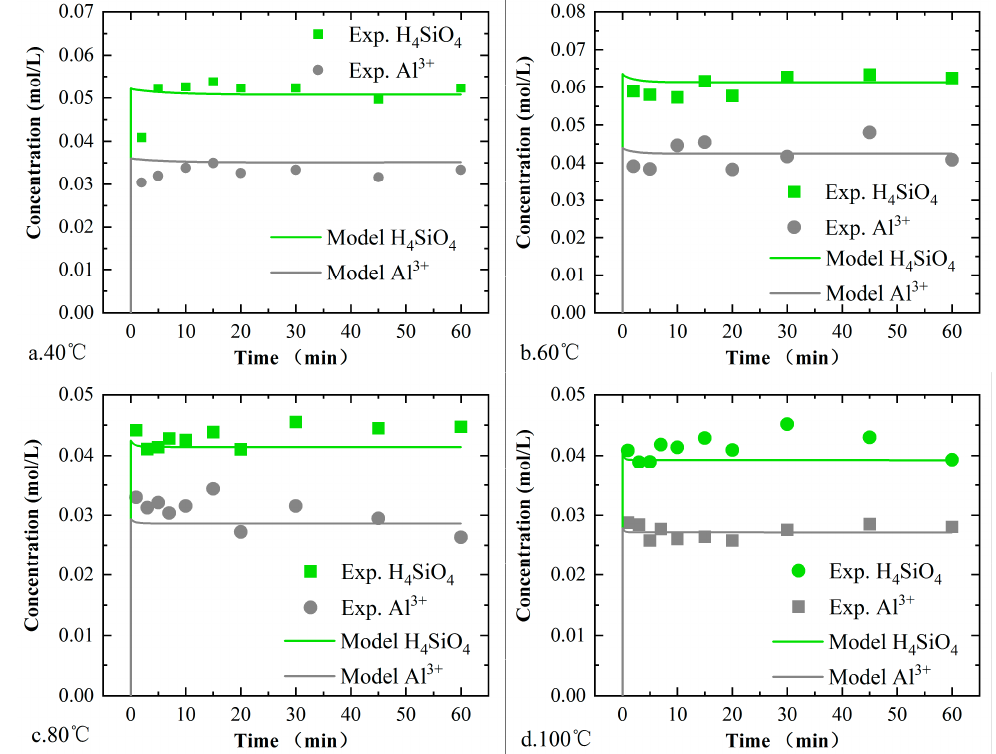
Figure 12. Comparison of H 4 SiO 4 and Al 3+ concentrations for R1 core.